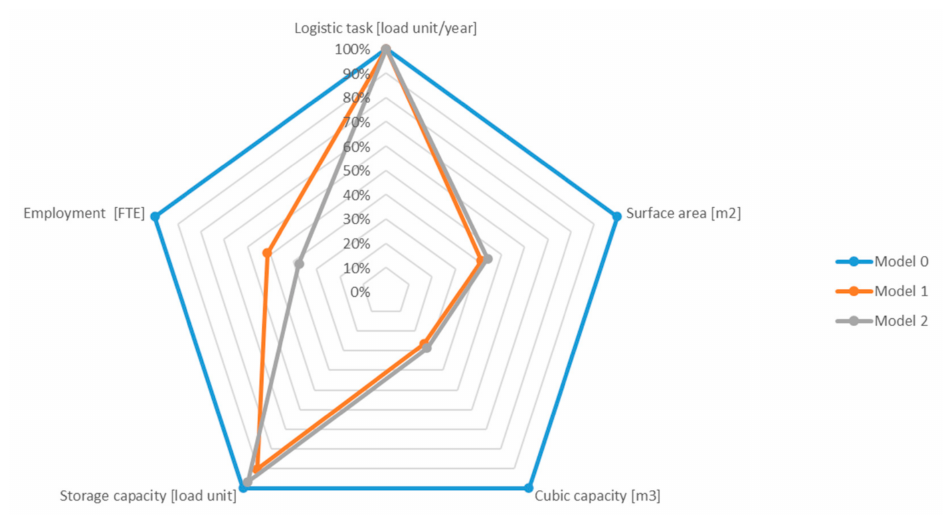
Figure 7. Results of the PL9A modeling of the Logistics System—Group 1–5 main parameters.